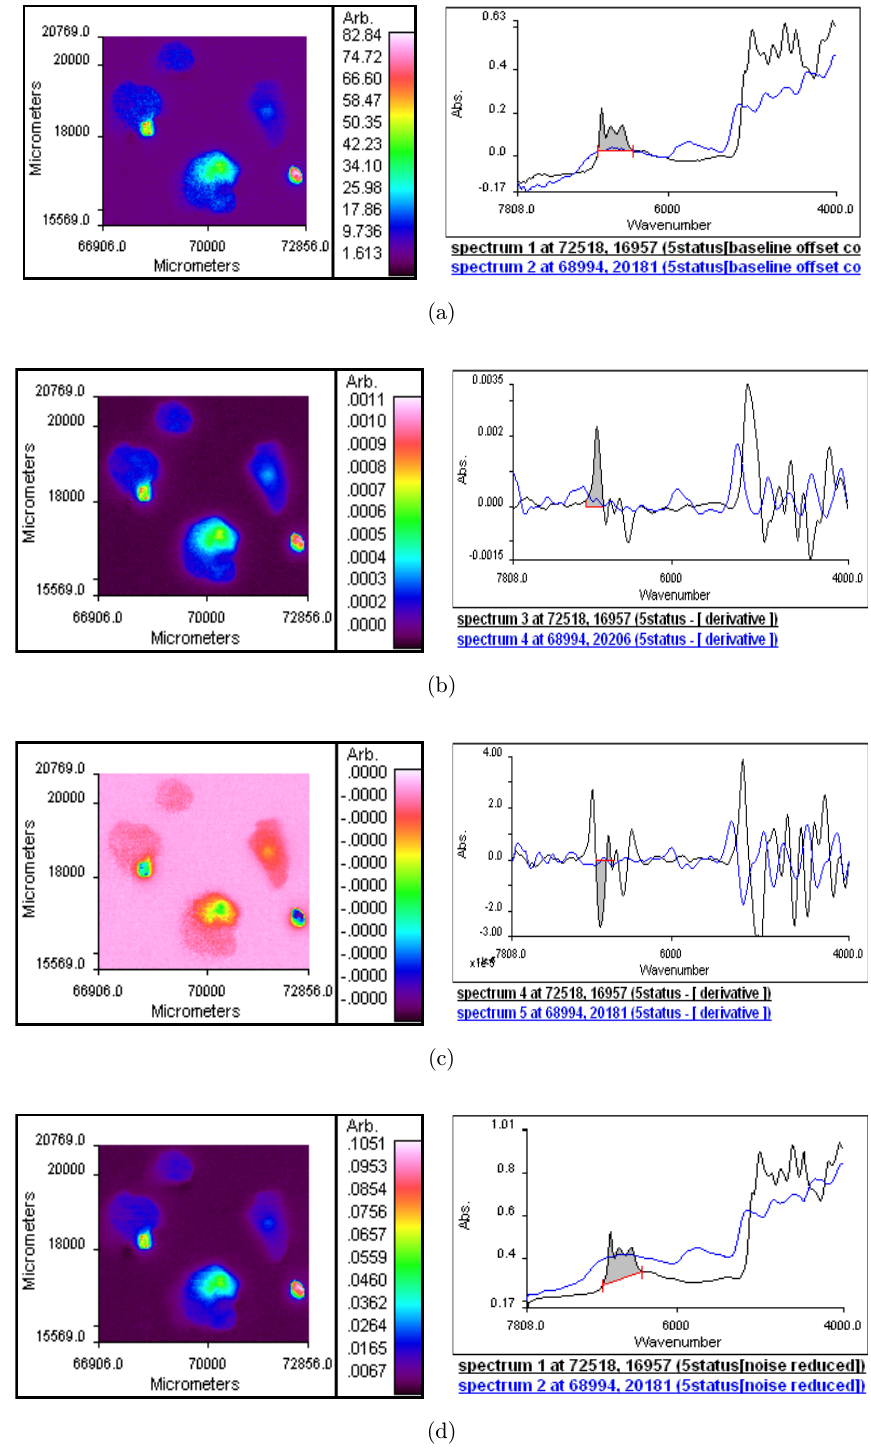
Fig. 4. Image under peak integration with di®erent preprocessing. (a) Baseline o®set correction (the area under 6846 – 6430 cm (cid:1) 1 with 2 base points). (b) First derivative (the area under 6980 – 6780 cm (cid:1) 1 without base points). (c) Second derivative (the area under 6860 – 6650 cm (cid:1) 1 without base points). (d) Noise reduction (the area under 6900 – 6430 cm (cid:1) 1 with 2 base